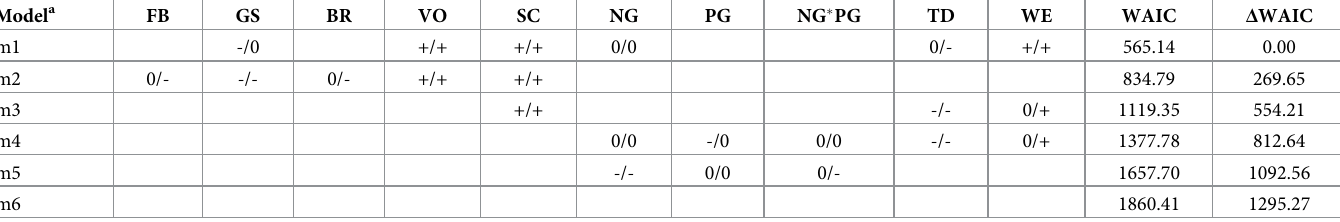
Table 2. Variables included in candidate models explaining fall (Nov) and winter (Dec–Jan) resource selection of Northern bobwhite in southwest Missouri, 2018– 2019. Variables with the proportion of the posterior distribution < 0.85 are indicated with a “0”, and variables with a proportion of the posterior distribution > 0.85 are indicated with “+” if the effect was positive or “-”if the effect was negative (fall/winter). Model support is indicated by the Watanabe-Akaike Information Criteria